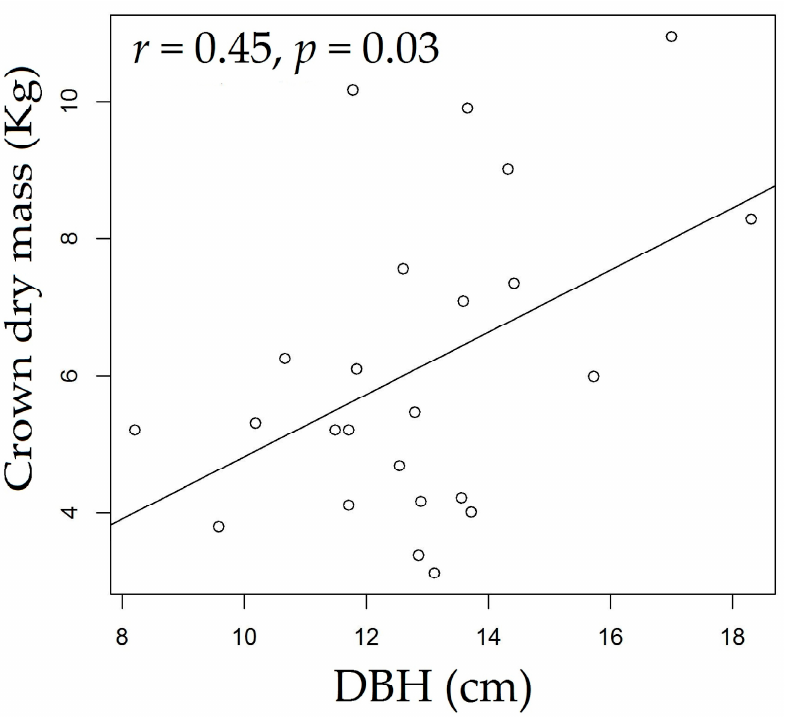
Figure A11. Correlation between crown dry mass resprouted and tree DBH in managed Central Amazonian rosewood plantations.